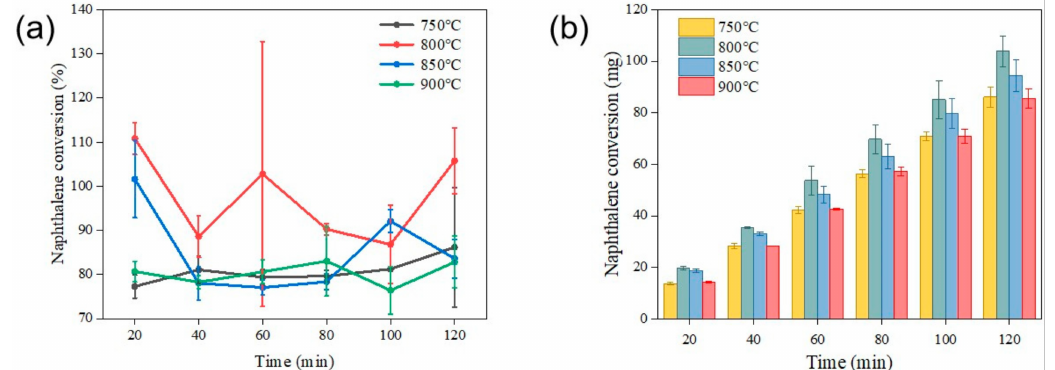
Figure 8. The Naphthalene conversion ( a ) rate (%) and ( b ) amount (mg) with different temperatures on tar catalytic reforming in 2